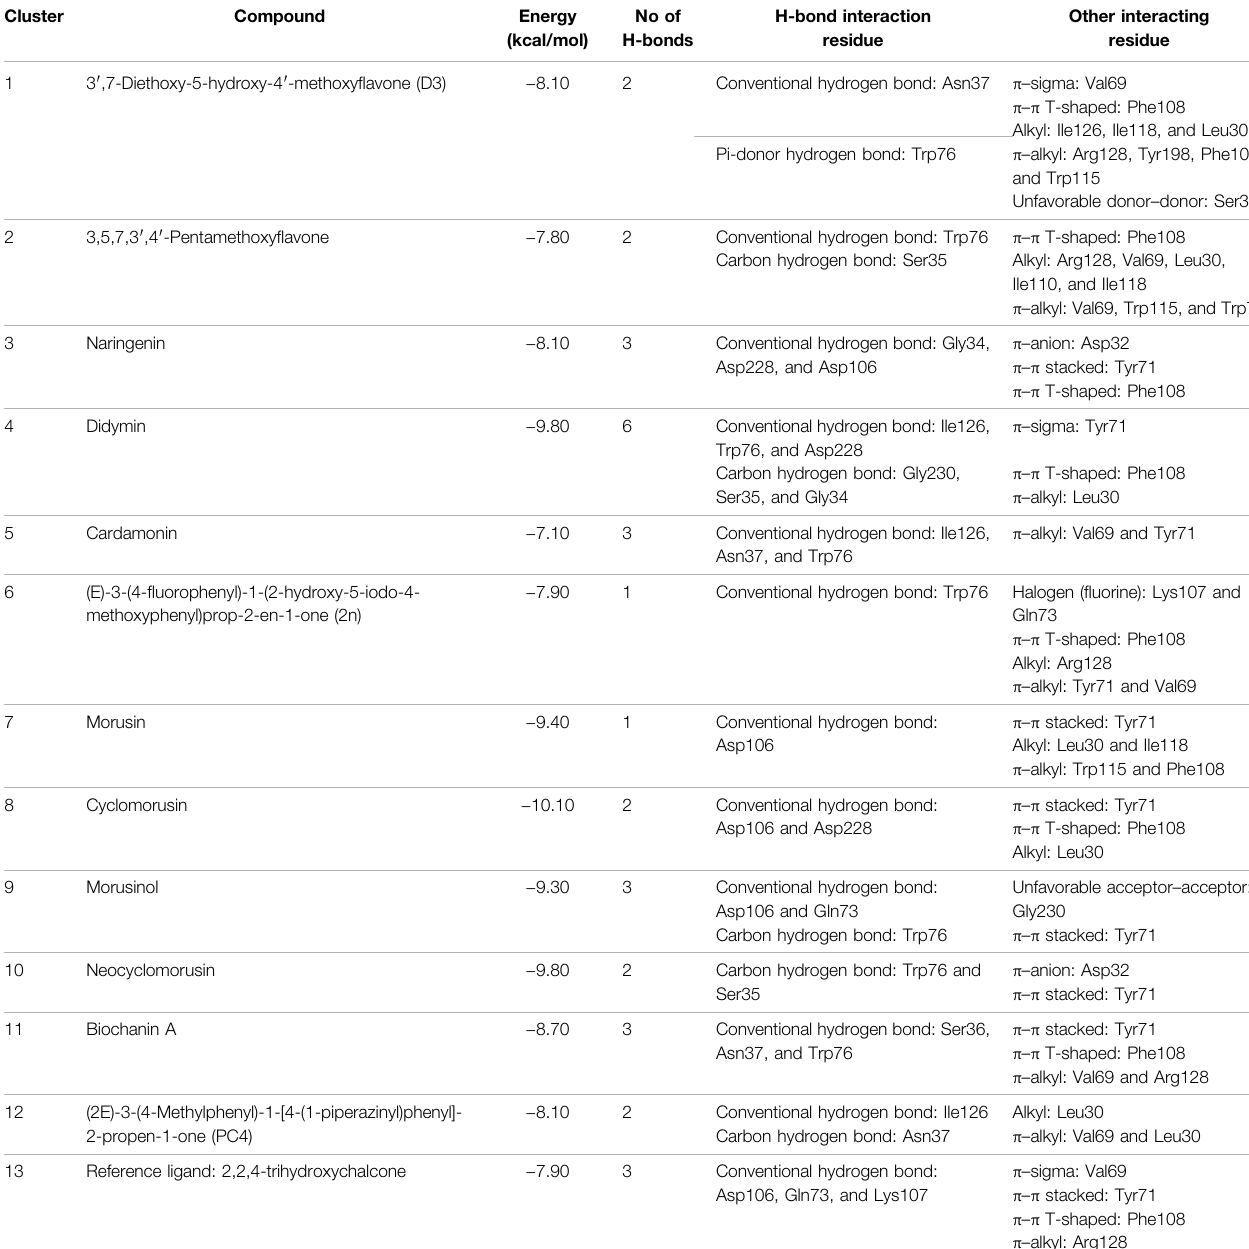
TABLE 4 | Result of the molecular docking of 12 compounds, which are representative of each cluster. Information includes the binding scores, number of hydrogen bond formed, residues involved in hydrogen bond, and others.